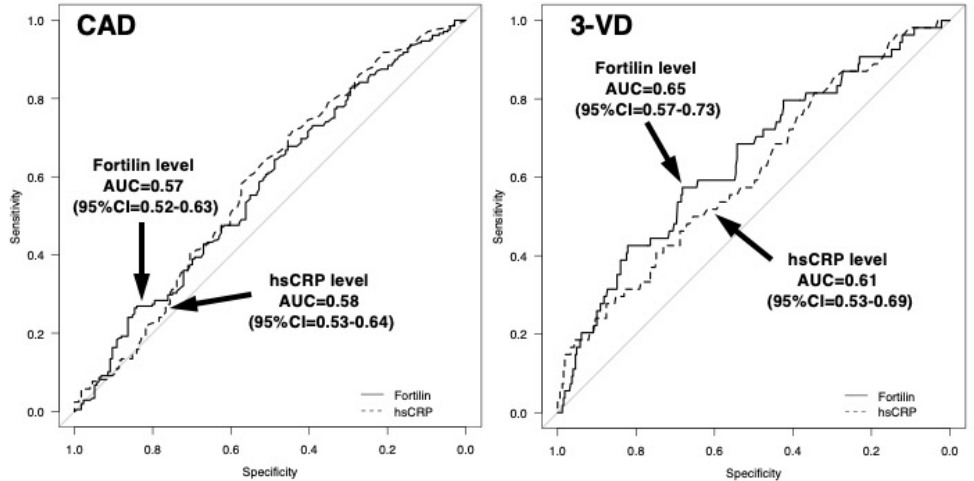
Figure 2. Correlation between fortilin levels and the severity score.